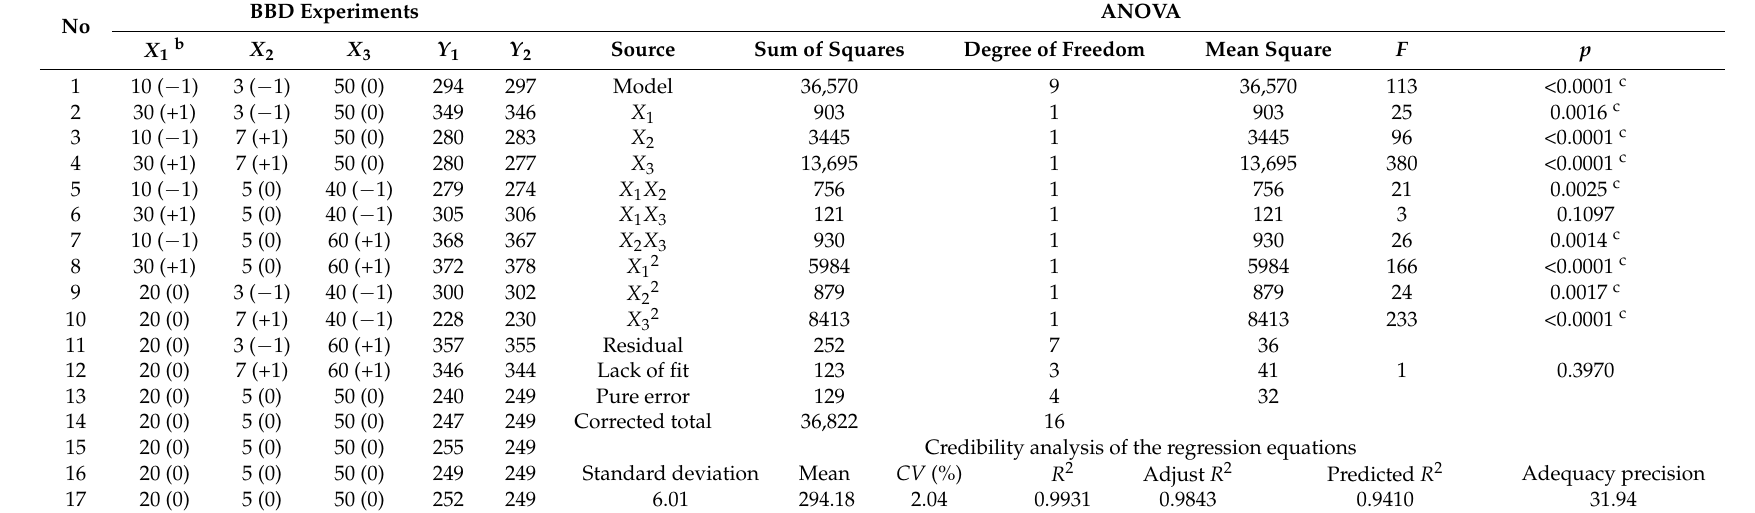
Table 1. Experimental design matrix to screen for variables that determine the MPS of spiramycin microparticles and ANOVA results a